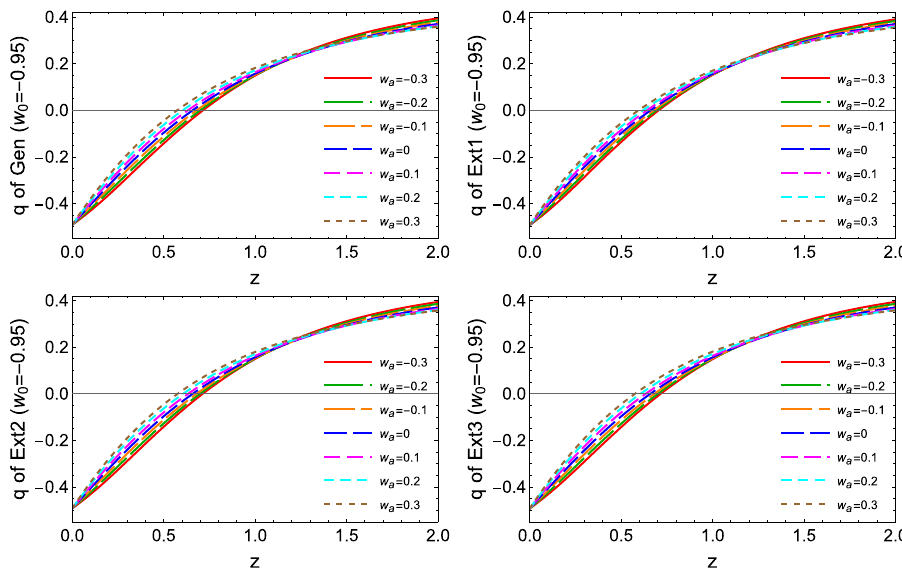
Fig. 2 The evolution of the deceleration parameter depicting a clear transition from the past decelerating phase to the current accelerating phase for all the dark energy models has been presented for different values of w a and with a fixed value of w 0 = − 0 . 95. One can easily notice that as long as w a increase from its negative to positive values, the transition redshift shifts more closer to the present